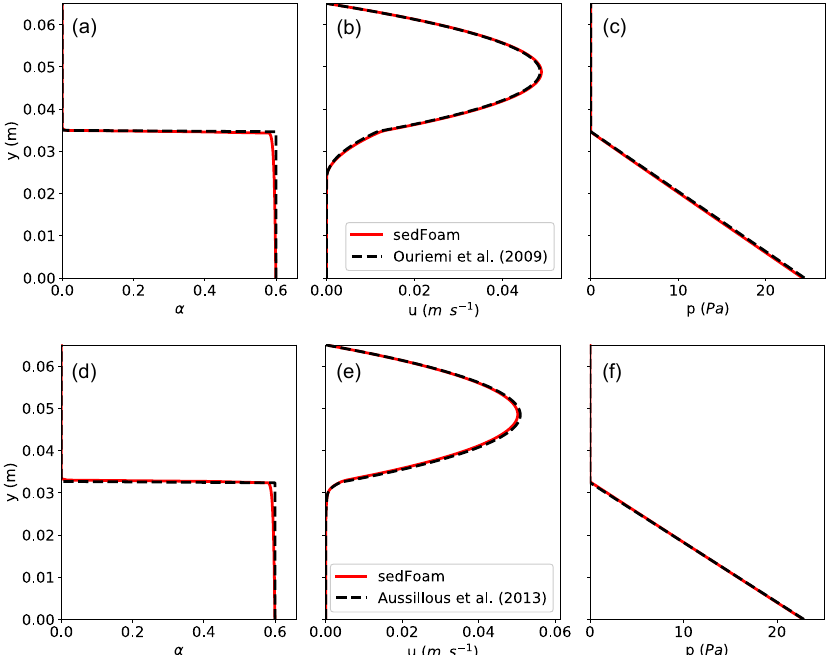
Figure 2. (a–c) Comparison of the streamwise velocity profiles for the flow of a Newtonian fluid over a granular bed having a Coulomb rheology between two infinite parallel planes obtained by numerical simulations with the analytical solution of Ouriemi et al. (2009) in terms of sediment concentration (a, d) , velocity profiles (b, e) , and particle pressure (c, f) profiles. In panels (d–f) the same flow conditions are used but the granular rheology is the µ(Iv) rheology and the results are compared with a one-dimensional numerical solution presented in Aussillous et al.